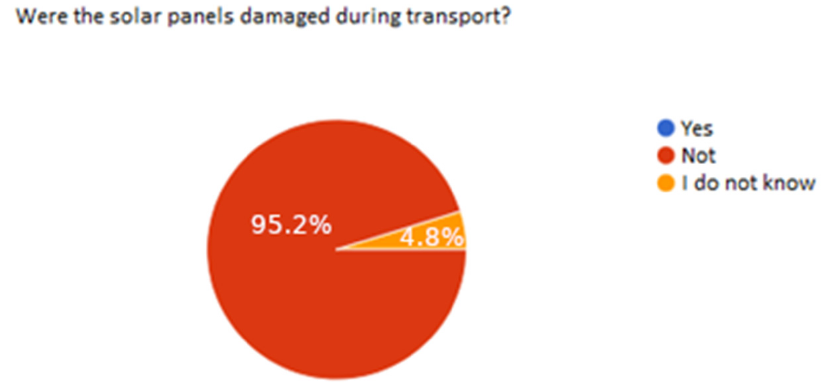
Figure 10. Damage to the photovoltaic system.